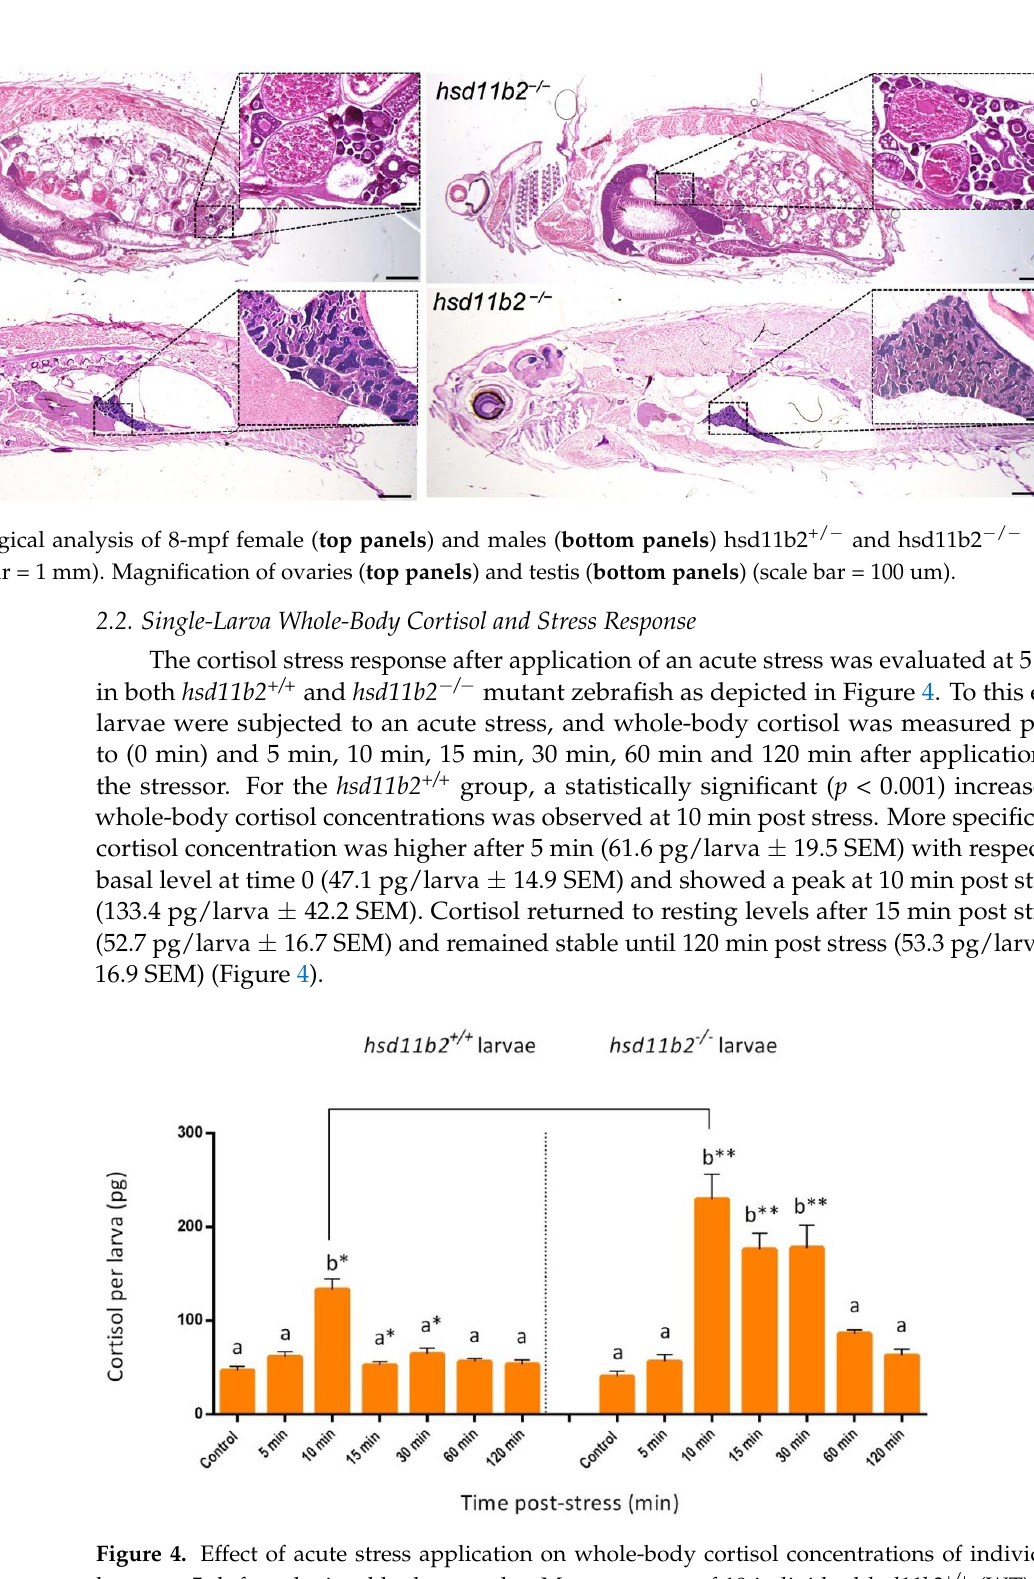
120 min after the stress application. Values are means ± SEM. Means with different letters differ